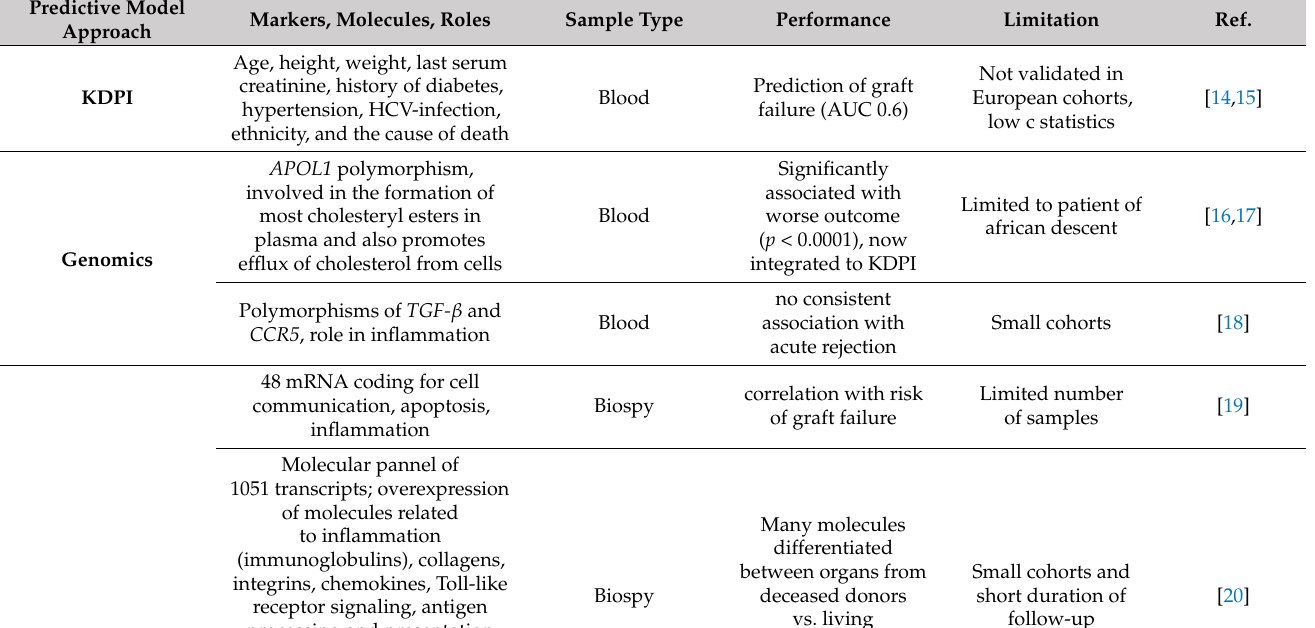
Table 1. Pre-transplantation molecular biomarkers; their role and the performance as predictive tools in